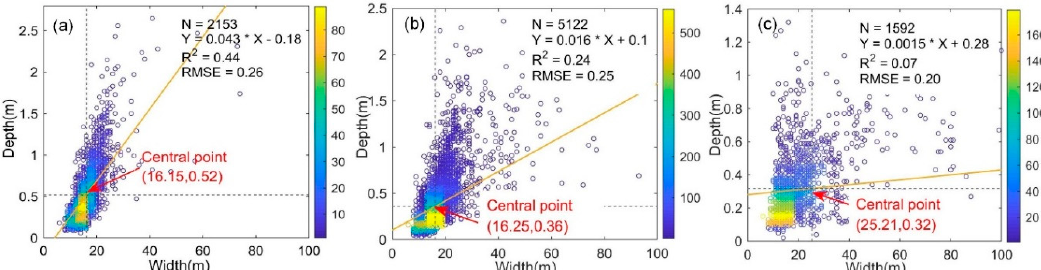
Figure 11. Scatter plots of width versus depth of the tidal creeks in ( a ) the salt marsh zone, ( b ) the mid-upper intertidal zone, and ( c ) the lower intertidal zone.